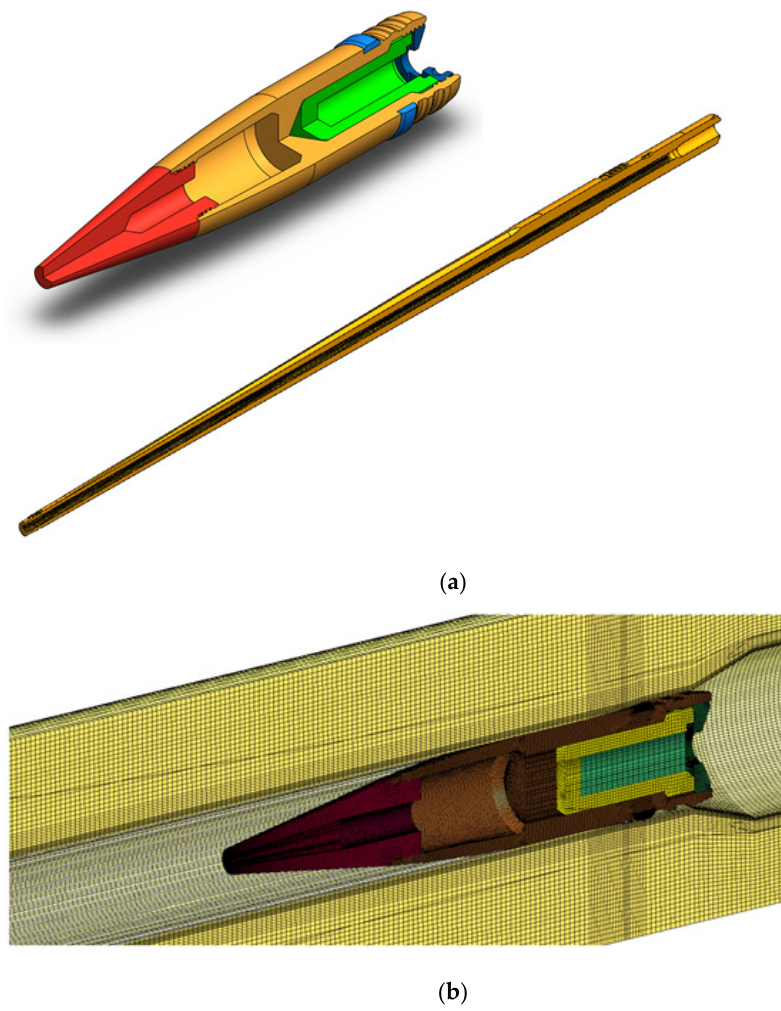
Figure 9. Geometry of the under-investigation system (( a )—exact geometry; ( b )—simplified and meshed geometry).